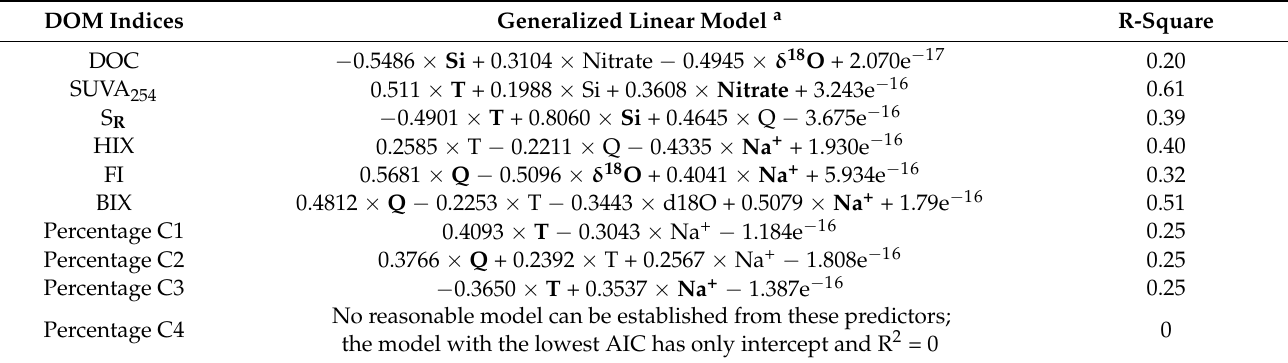
Table 2. The generalized linear models predicting DOM indices in Mayfield Creek, the southeastern United